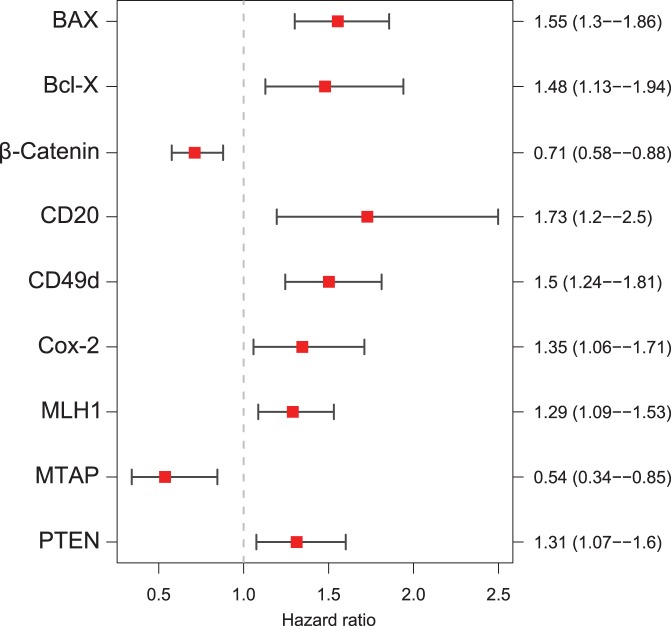
Hazard Ratios of the Nine-Marker Signature learned by the FDR selection procedure.Markers with a hazard ratio smaller than 1.00 represent “protective markers” (MTAP, β-Catenin). Those with hazard ratios larger than 1.00 represent “risk markers” (Bax, Bcl-X, infiltration with CD20 positive B-lymphocytes, CD49d, COX-2, MLH1 and PTEN).